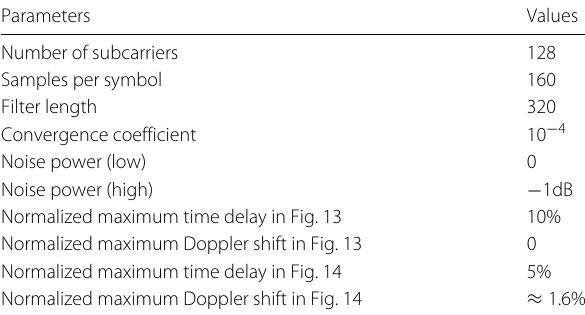
Fig. 12 a – d SINR contour of g RECT ( solid ) and g RC ( dashed ) w.r.t. max-SINR receiver